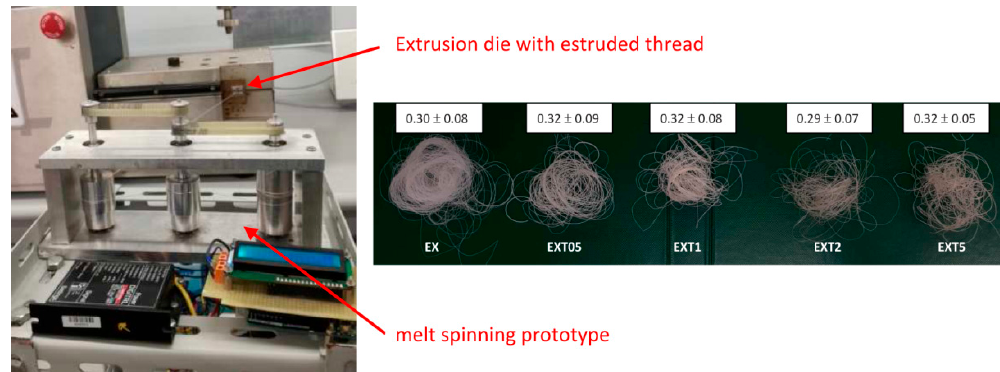
Figure 1. Thespinning process for thread production ( left ); the image of the threads, with the average diameter expressed in mm ( right ).